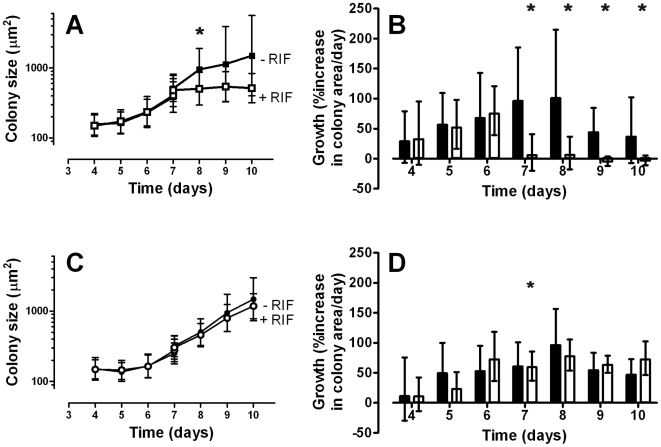
Growth of strains H37Ra and HR1 in the presence of RIF.Microcolonies of RIF susceptible strain H37Ra and resistant strain HR1 were grown without RIF for 7 days, then moved to fresh agar with or without RIF from day 7 onwards. A, C: Averaged sizes of H37Ra (A) and HR1 (C) colonies incubated with (open symbols) and without RIF (closed symbols). Average colony size is plotted; bars indicate ±1 standard deviation of measured colony sizes. A statistically significant difference (indicated by an asterisk (*), p<0.001) between the groups at day 7 and 8 (unpaired T-test) was found between H37Ra with and without RIF at day 8. B: Growth rate of individual H37Ra (B) and HR1 (D) colonies incubated with (white bars) and without (black bars) RIF. Statistical analysis was performed using a paired T-test on colony growth between day 6 and day 7, and day 6 and day 8. Statistical significance is indicated by an asterisk (*; p<0.001). Although there is a statistically significant difference between the growth rate of HR1 at day 6 and 7 in the presence of RIF, the change in growth rate is so small compared to the sensitive strain that we consider this effect irrelevant.